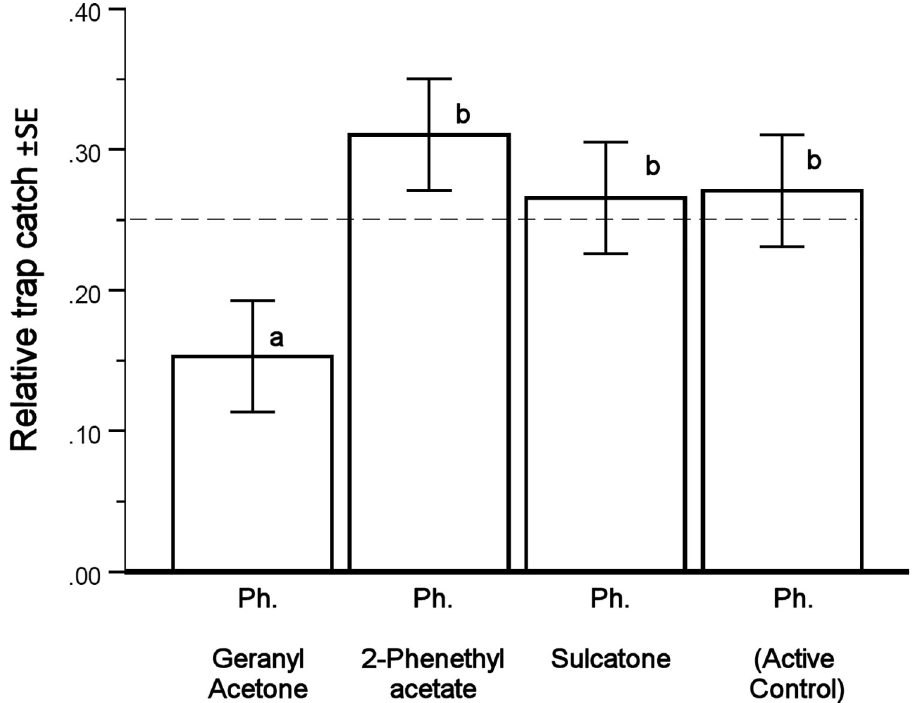
Fig 5. Mean relative catches ( r ) of I . typographus , calculated from EMM (Estimated marginal means) of SPSS UNIANOVA. The thin dashed reference line at 0.25 shows the zero hypothesis that all four treatments had the same catch (1/4 of total). Only the addition of Geranyl acetone ( 6 ) to synthetic pheromone (Ipslure 1 ) resulted in a catch significantly lower than the catch of the Control (synthetic pheromone alone). Bars with the same lower-case letters (a or b) did not statistically differ from each other by sequential Sidak post-hoc contrasts following GzLM (Omnibus test [fitted model against the intercept-only model] likelihood ratio χ 2 10.98, df 3, p = 1.2 * %, SPSS